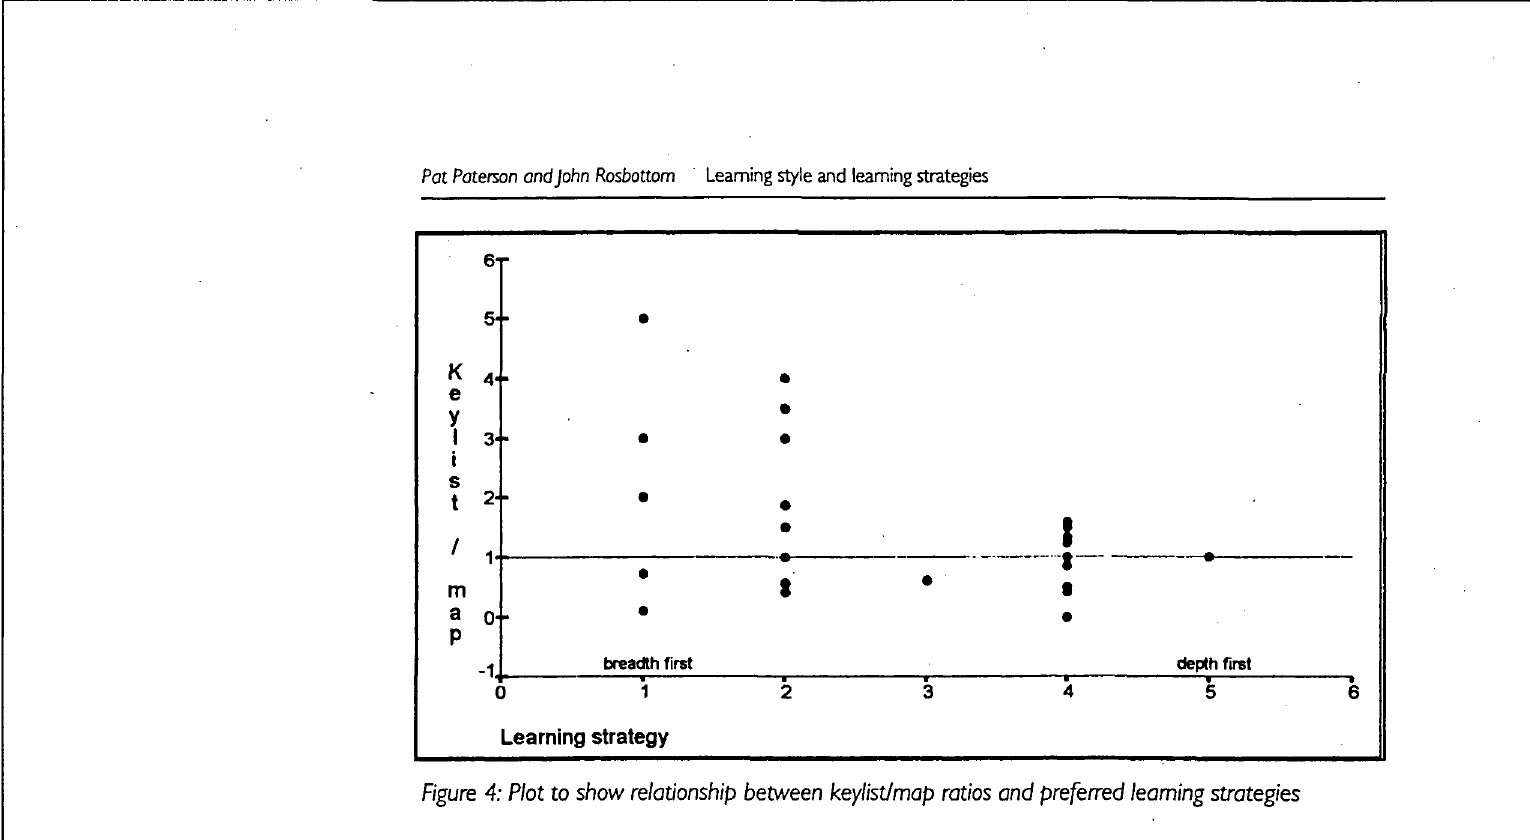
Figure 4: Plot to show relationship between keylist/map ratios and preferred learning